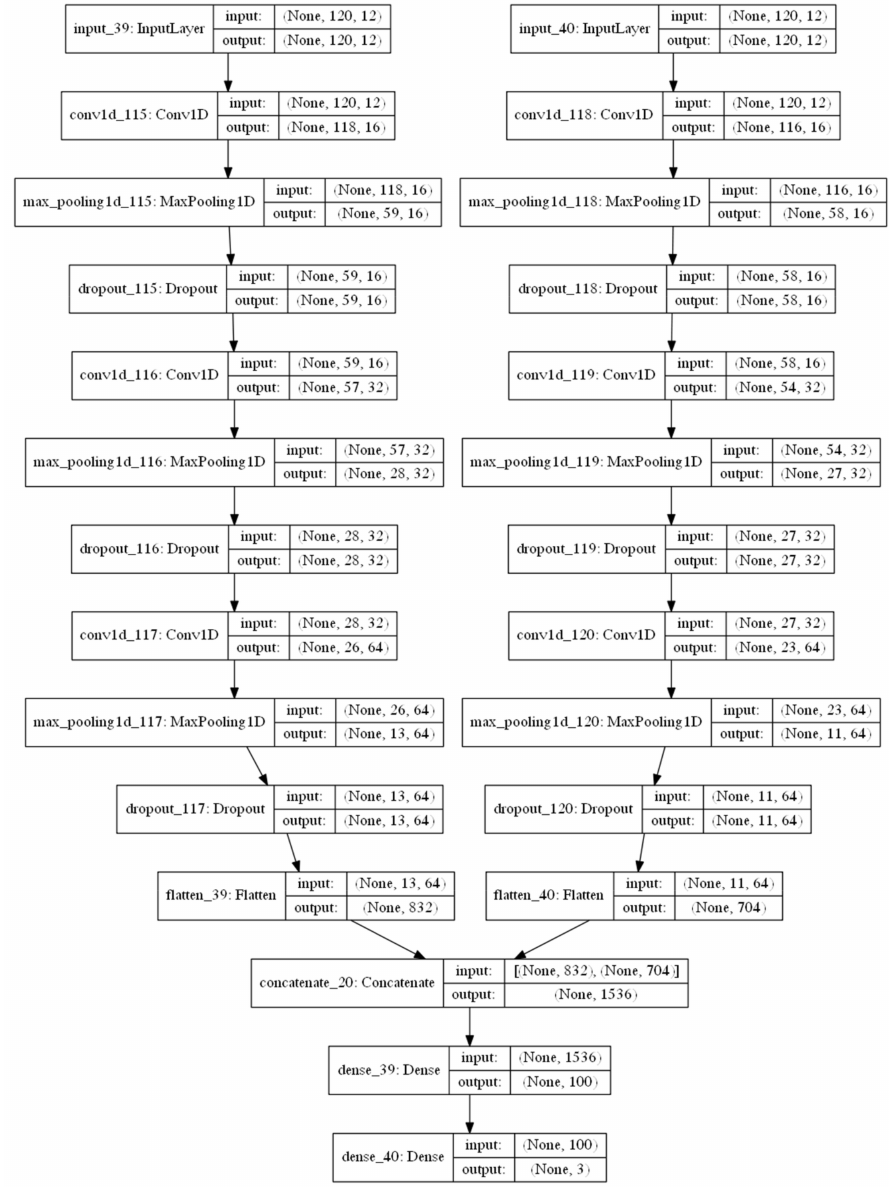
Figure 7. The two-headed convolutional neural